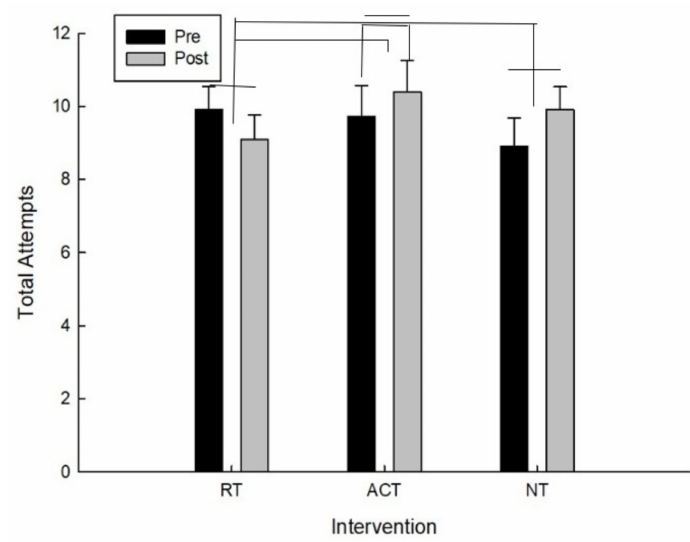
Figure 5. Total attempts as a function of time and